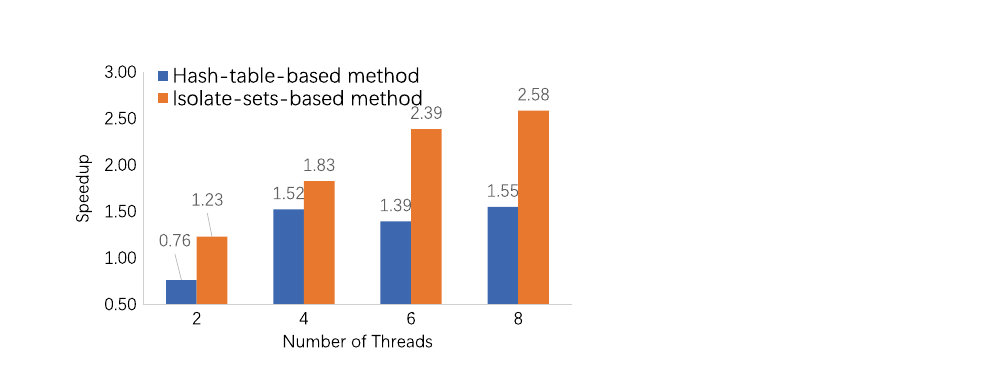
Figure 2. Speedup on dataset wikipedia. Our method has an obviously higher speedup than the hash-table- based